Question: Write a single sentence explaining what this figure depicts.
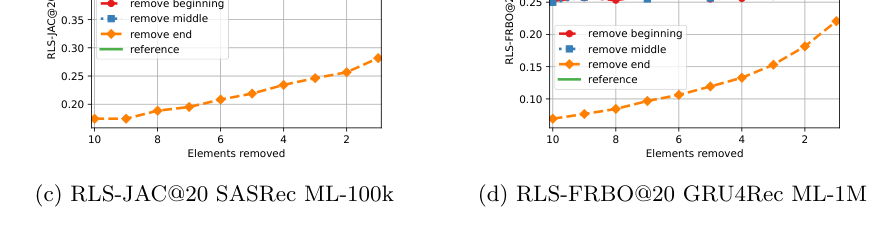
Answer: Plots of various metrics for the ML-100k and ML-1M datasets as the number of removed elements increases. The baseline is shown as a horizontal solid line, while dashed lines show the metrics as the number of items removed changes for the three scenarios considered.